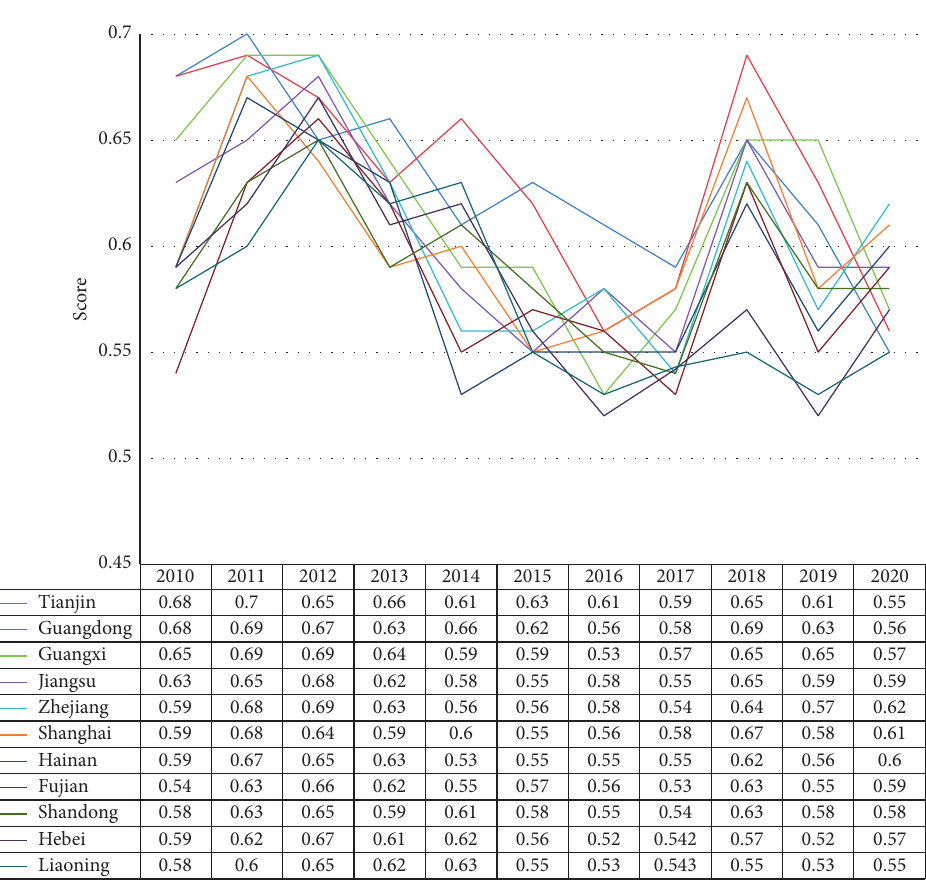
Figure 11: Composite scores of economy subsystem of coastal provinces in